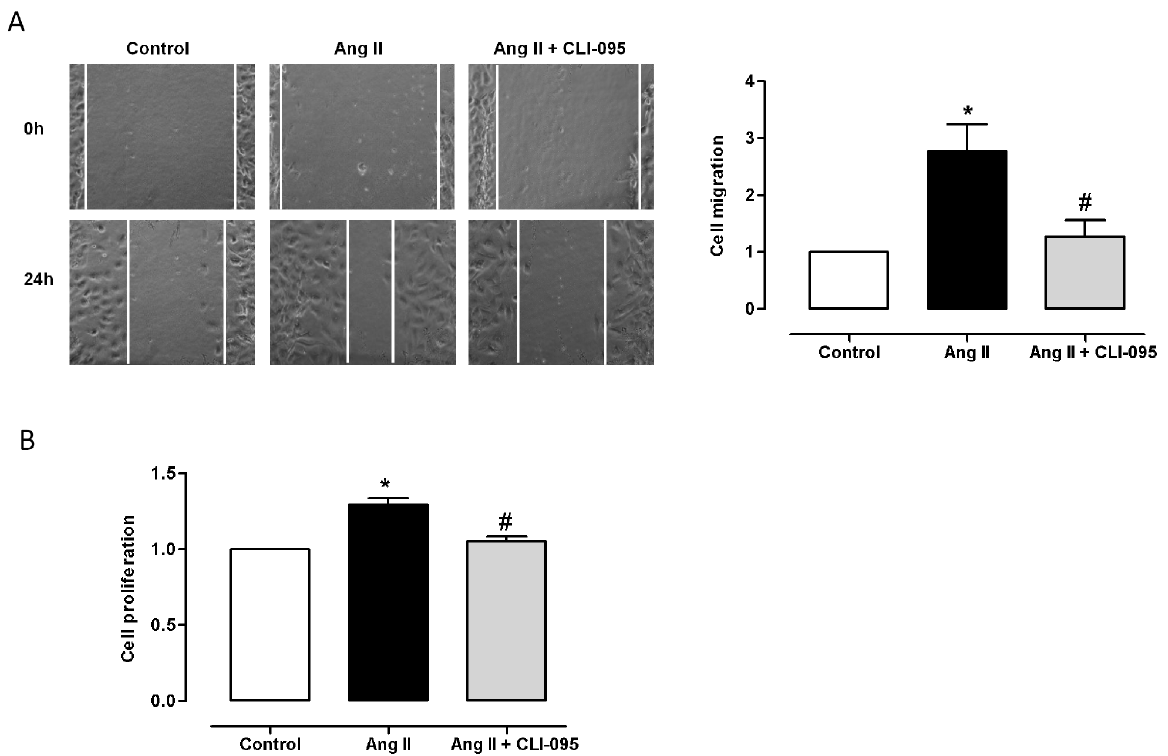
Figure 9. TLR4 inhibition reduces Ang II-induced cell migration and proliferation. (A) Wound healing assay showing SHR VSMC migration in response to Ang II (100 nM, 24 h) and effect of CLI-095 (1 m M, 1 h). (B) Effect of CLI-095 on Ang II-induced proliferation. The results (mean 6 SEM) are expressed as relative values compared with the control. *P , 0.05 vs Control, # P , 0.05 vs. Ang II using Student’s t-test. n=5.